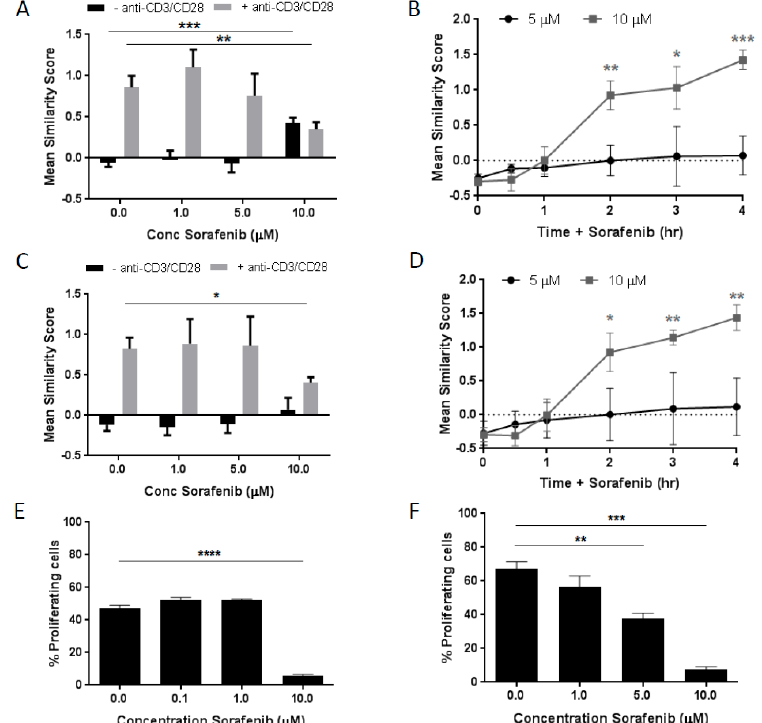
Figure 1. Sorafenib has dose- and time-dependent effects on nuclear factor of activated T cells (NFAT) nuclear localization in T cells. ( A ) NFAT1 nuclear localization, measured by mean similarity score by imaging flow cytometry, exhibits a dose-dependent increase without T-cell receptor (TCR) stimulation (-anti-CD3/CD28 antibodies), and decreases with anti-CD3/CD28 antibodies in CD8+ T cells, ( C ) similar results observed in CD4+ T cells. ( B )Mean similarity score has a time-dependent increase with high dose sorafenib (10 µM) in CD8+ T cells, ( D ) similar results observed in CD4+ T cells. ( E ) Graph shows results from one-way mixed lymphocyte reaction (MLR) in human T cells stained with carboxyfluorescein succinimidyl ester (CFSE) in the presence of increasing sorafenib concentrations. ( F ) Graph shows results from a similar one-way mixed lymphocyte reaction (MLR) in woodchuck T cells. All experiments are at least n = 3, * p < 0.05, ** p < 0.01, *** p < 0.001 by Student’s t - test.